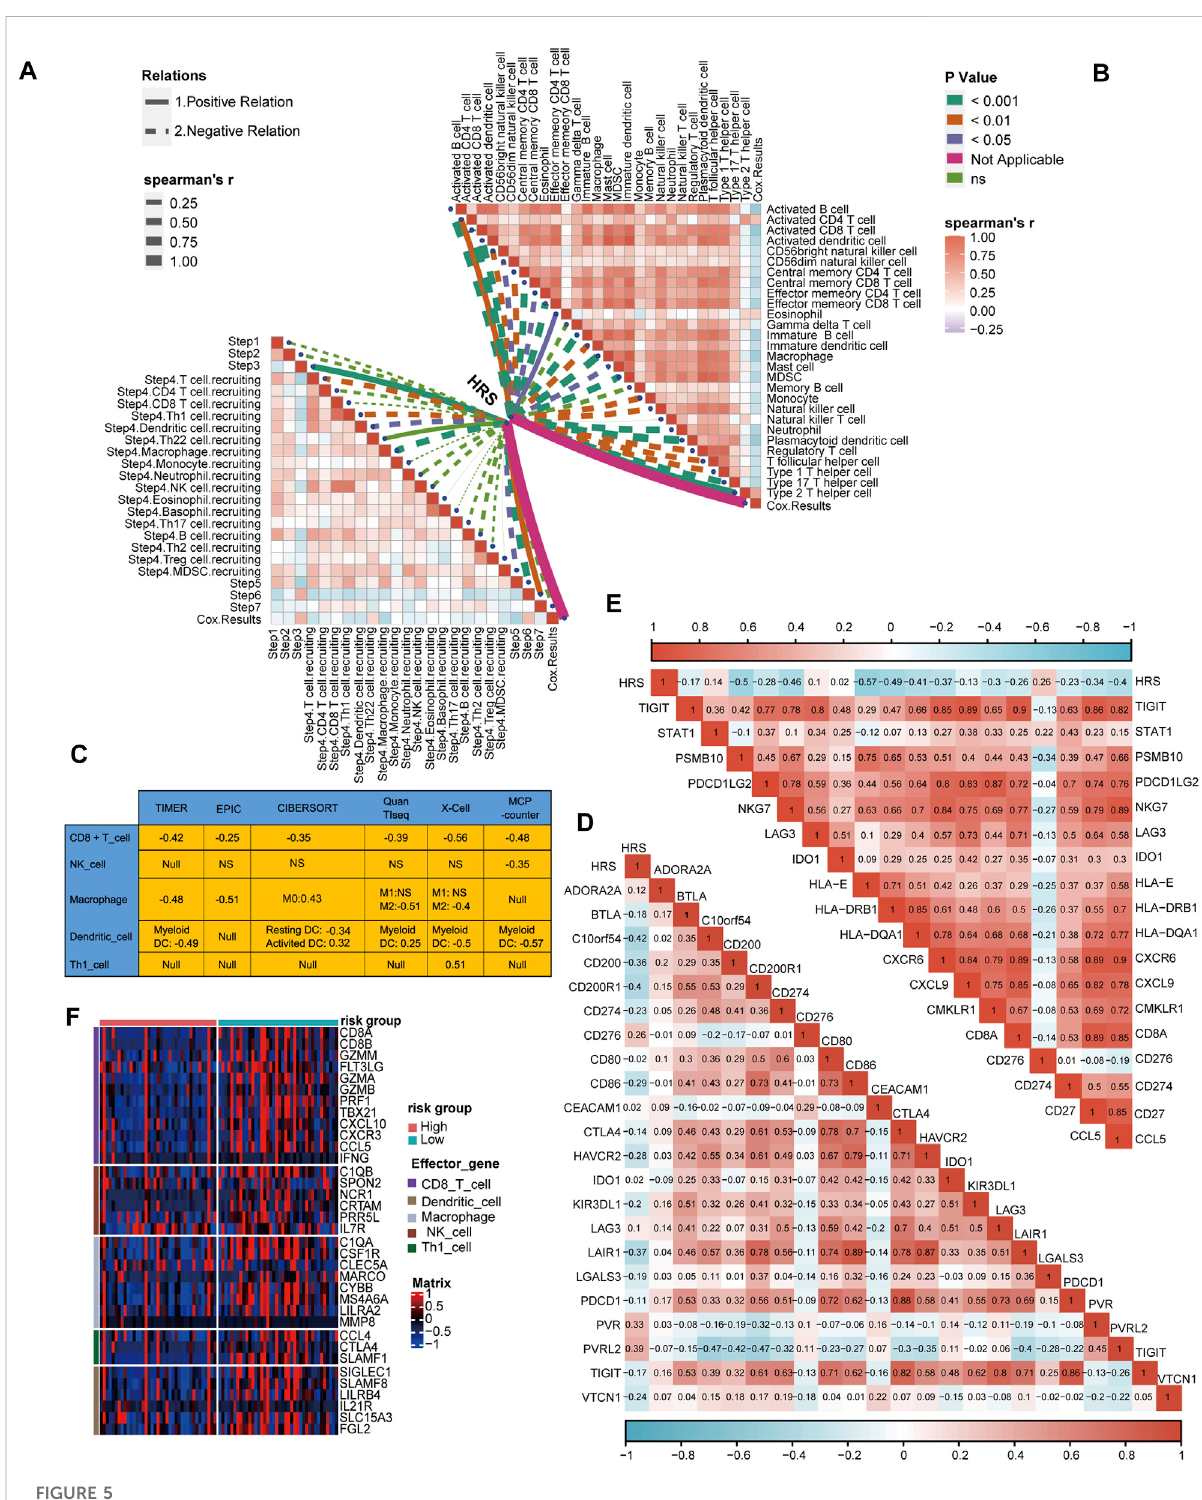
FIGURE 5 Differences in immunological characteristic between HRS groups. (A, B) Spearman correlation analysis of HRS with activity of cancer immunity cycleandimmunecellinTMEanalyzedbyssGSEA.Thepositivecorrelationisshowninsolidline.Thenegativecorrelationisshownindottedline.The association strength was represented by the thickness of the lines. The different colors of the lines represent different p -values. (C) The associations between the HRS and the several anti-tumor immune cell in six different algorithms. (D) The correlations between HRS and immune checkpoint. (E) The correlations between HRS and T cell in fl amed score. (F) A heatmap was drawn to depict the differences in cytotoxic effector molecule between high-risk score group and low-risk